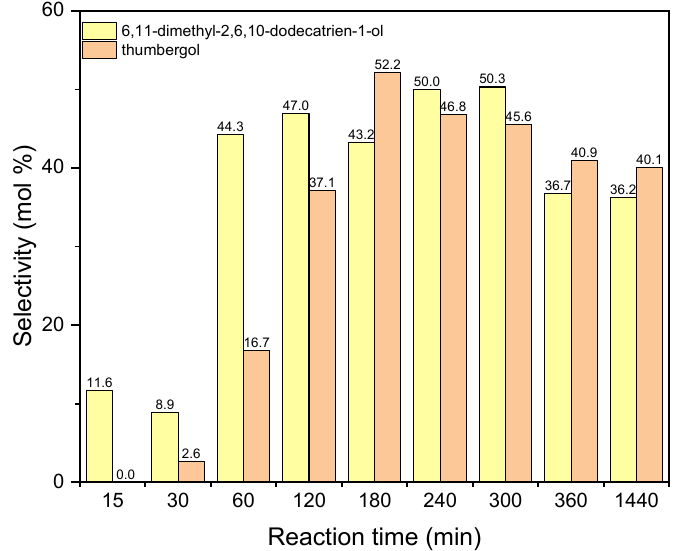
Figure 14. The influence of reaction time on the selectivities of the appropriate products over aluminium potassium alum as the catalyst.